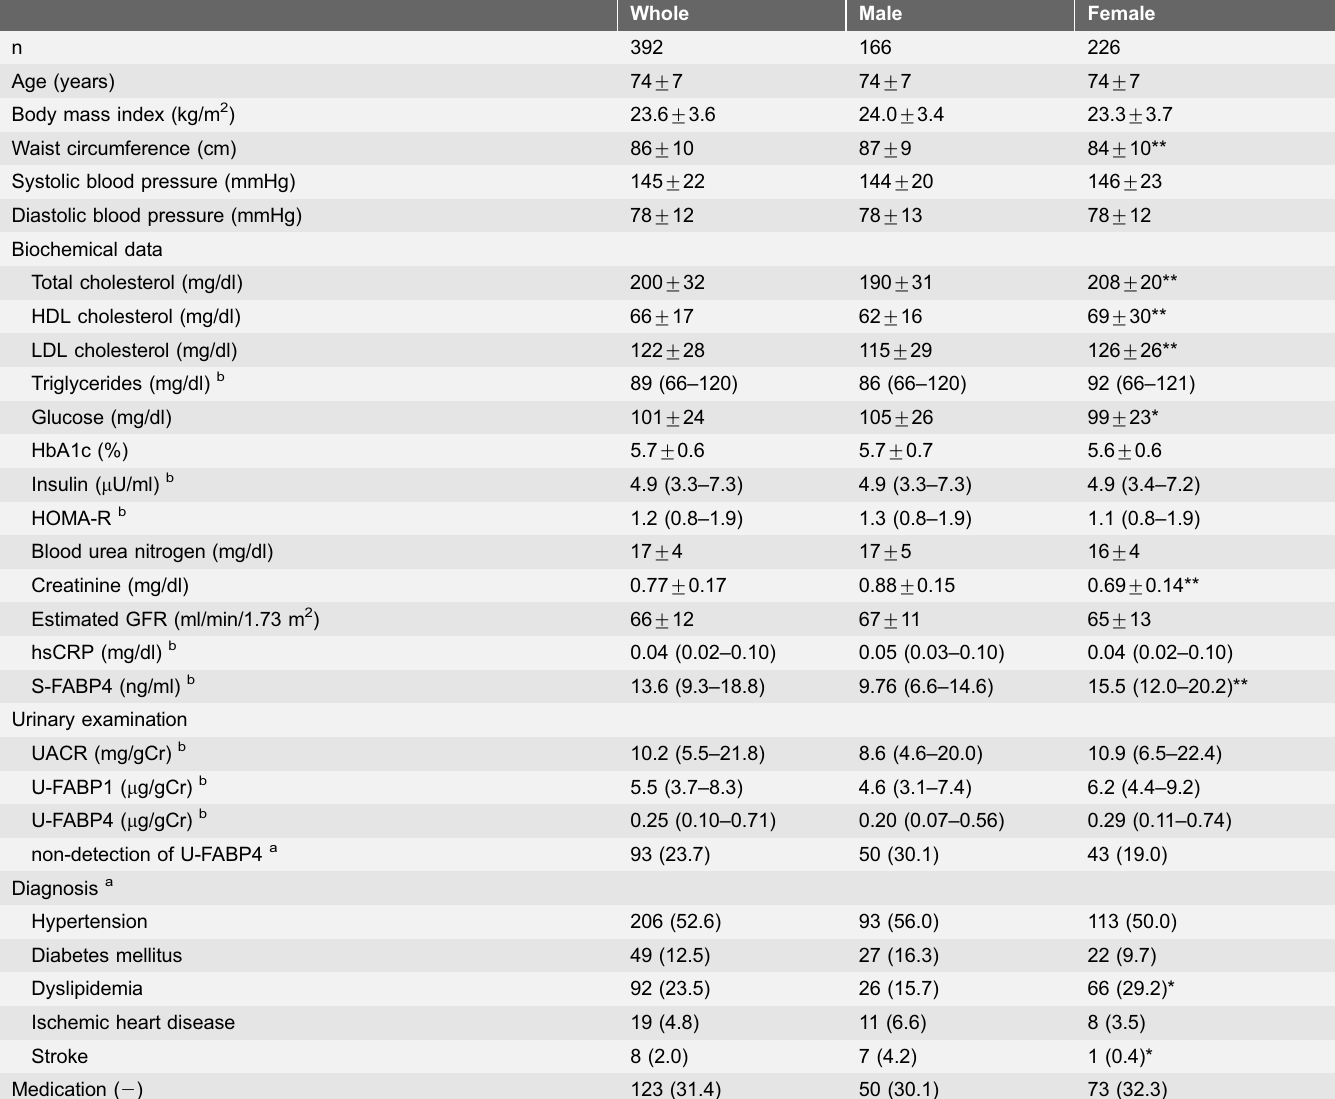
Table 1. Characteristics of the studied 392